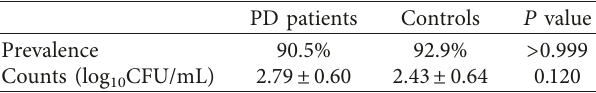
Table 3: Prevalence and quantification of Staphylococcus spp. in the oral cavity of PD patients and